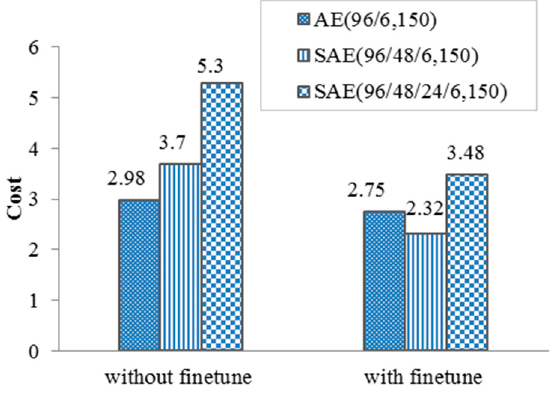
Figure 9. The compression costs of different SAEs on case 1.